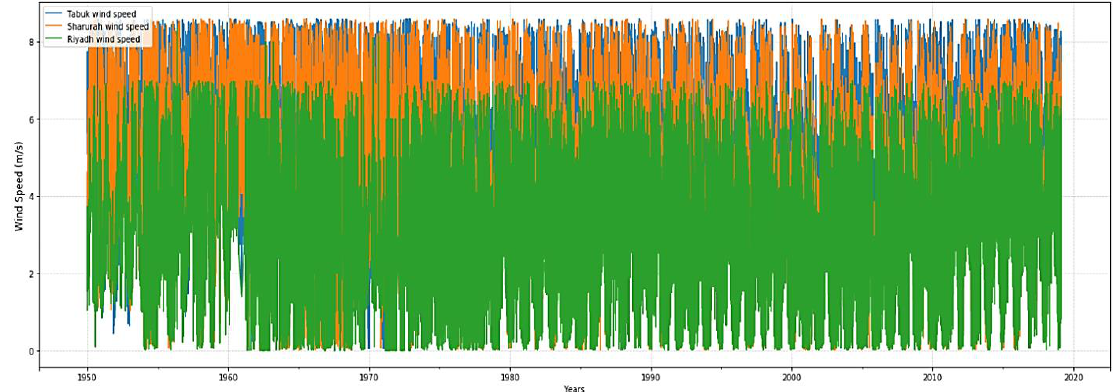
Figure 4. The wind speed performance of the three regions.